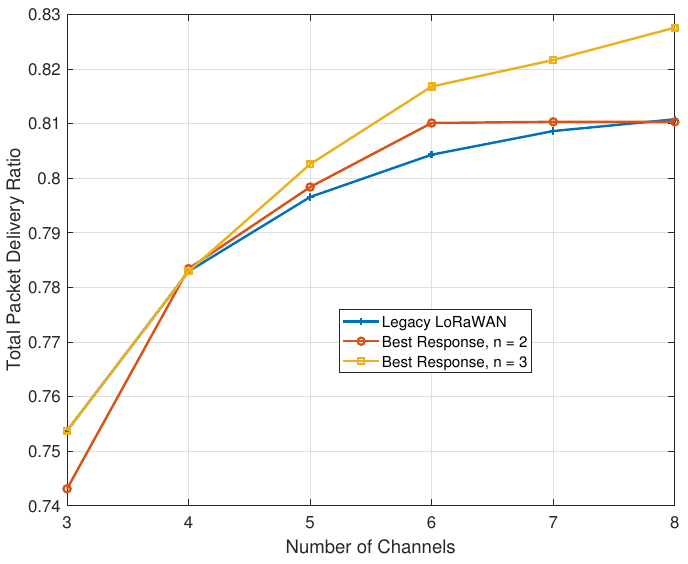
Figure 7. Impact of added channels on the total packet delivery